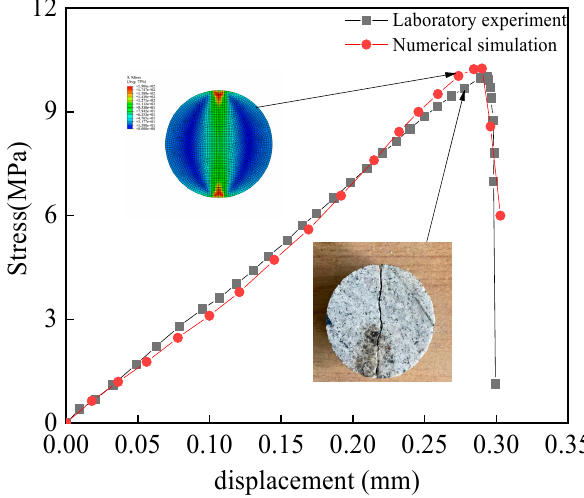
Figure 11. Comparisons of the stress–displacement curves measured in numerical simulation and laboratory experiments.